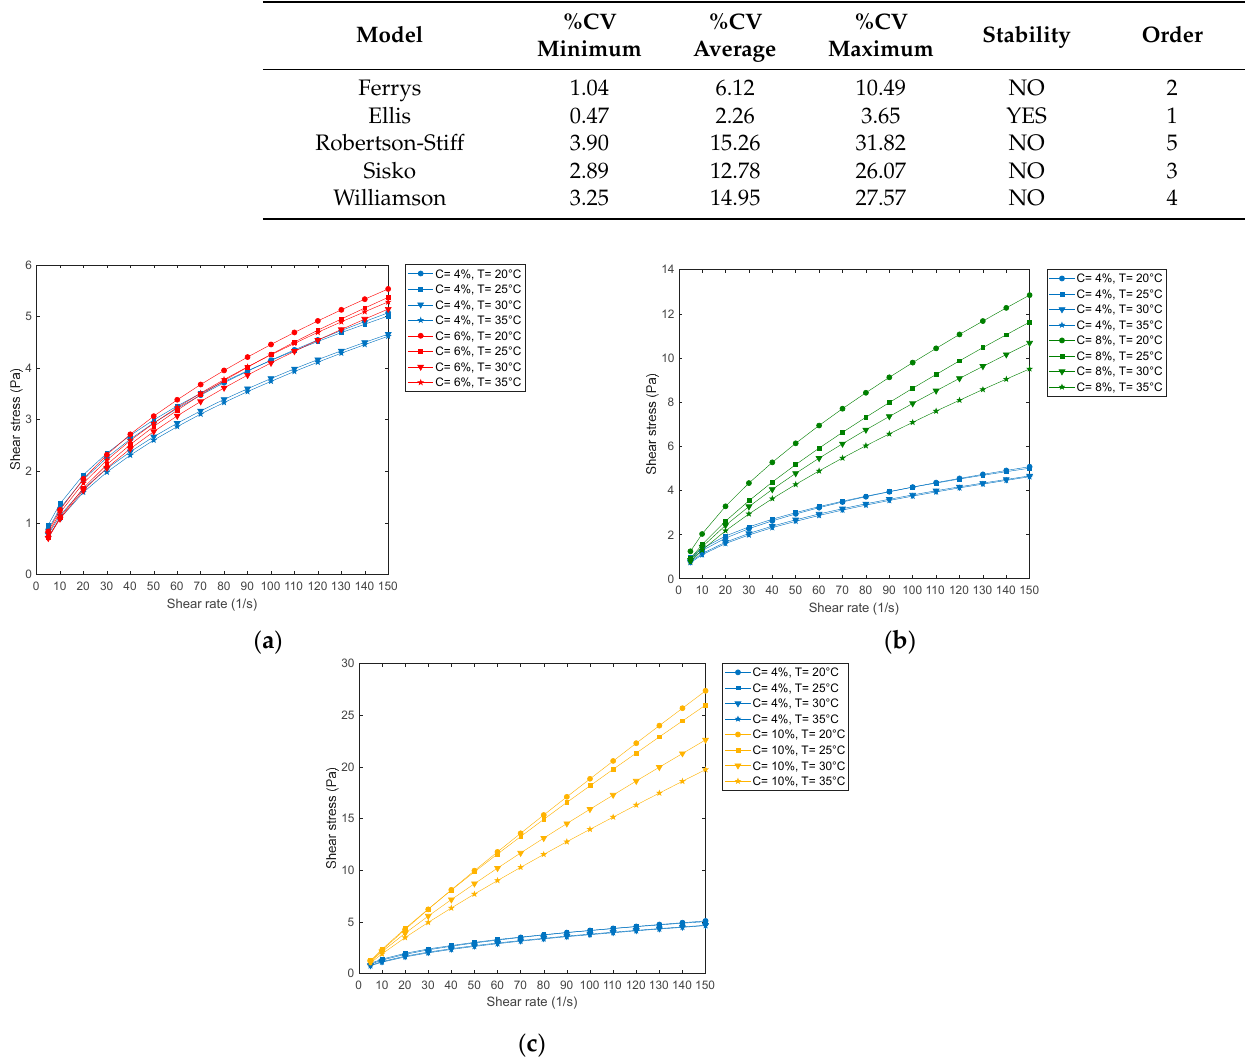
Figure 4. Compared shear stress rheograms for PVA of 4% and of ( a ) 6, ( b ) 8 and ( c ) 10%.